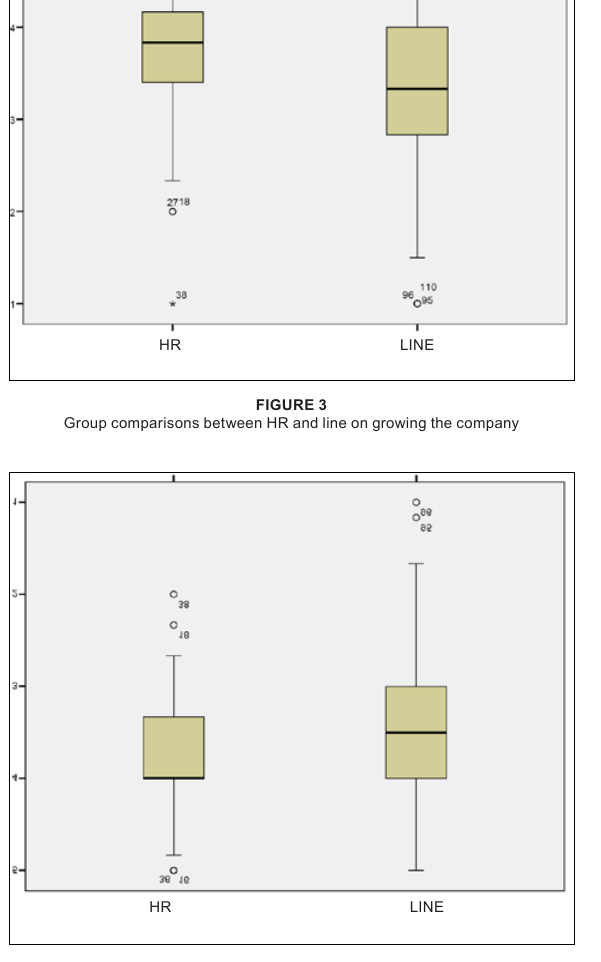
FIGURE 4 Group comparisons between HR and line on securing the